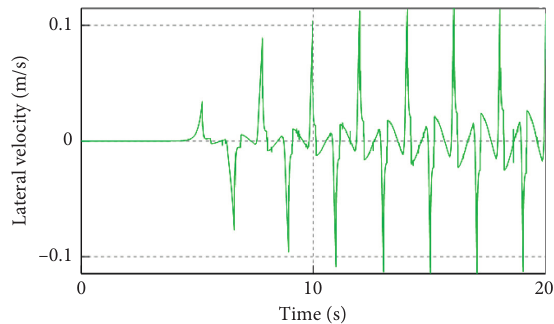
Figure 5: Change of the lateral velocity of the vehicle using a single- bogie structure on straight driving.